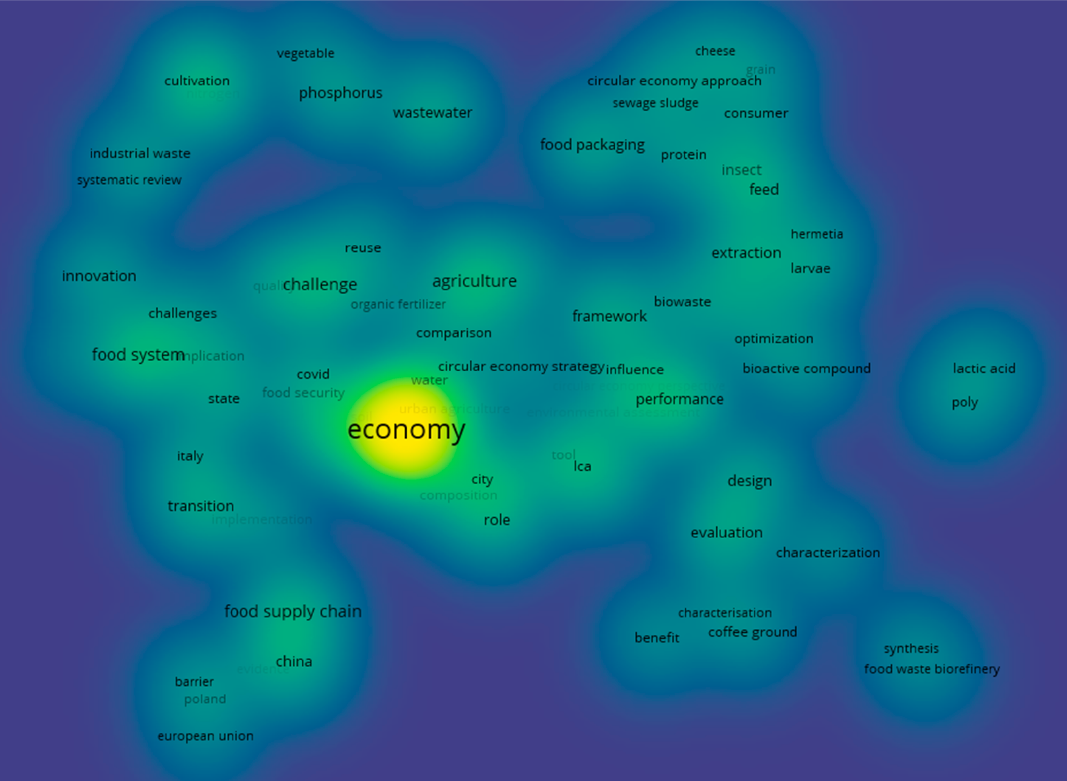
Figure 5. Keywords co-occurrence map density on circular economy and food during 2012–2021. Source: Authors’ elaboration.